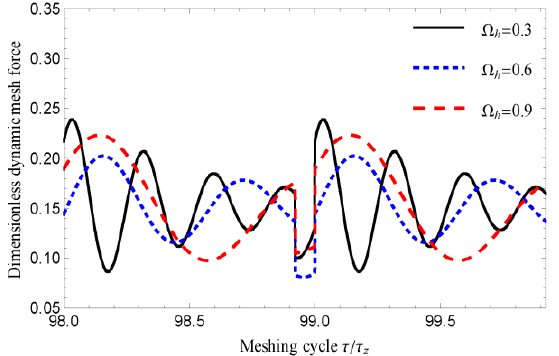
Figure 19. Total dynamic mesh force under different 𝛺 ℎ .